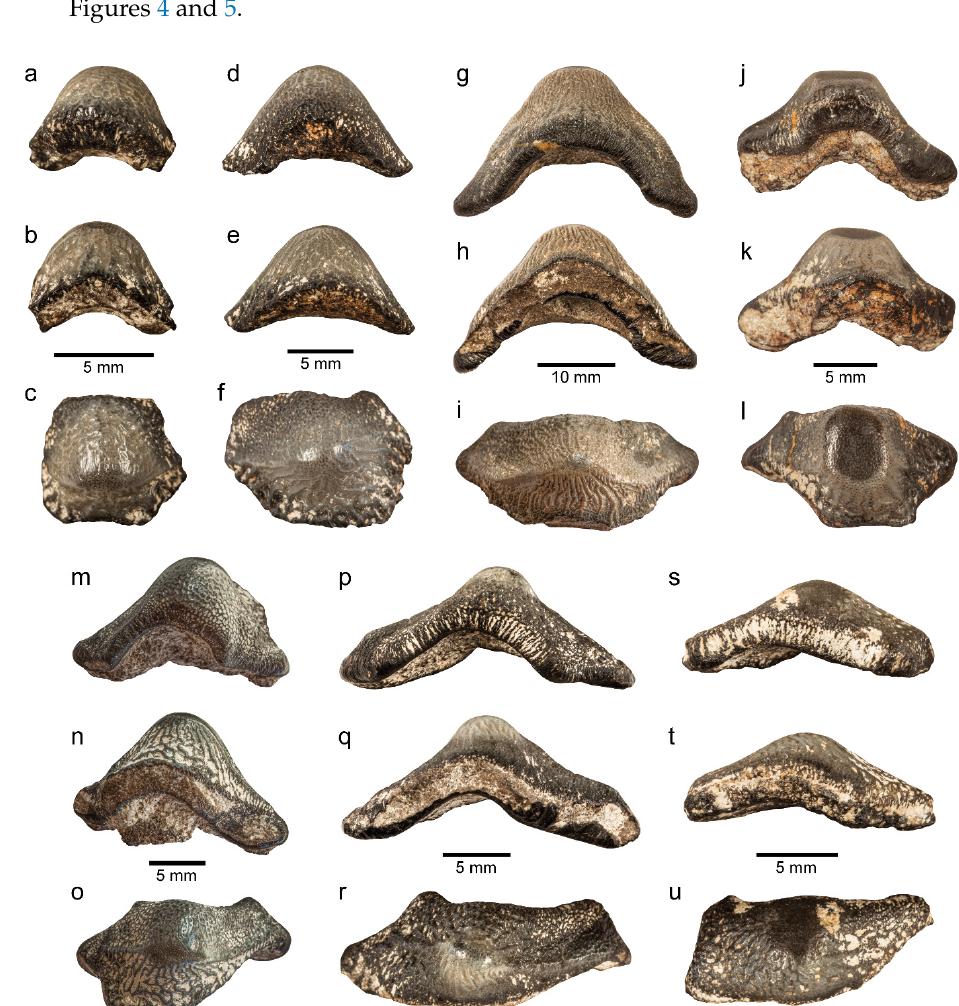
Figure 4. Historically collected hybodontiform teeth from the lower Kimmeridgian of Czarnogłowy, Poland. Strophodus udulfensis (Leuzinger et al., 2017). ( a – f ) Symphyseal teeth; GG 303/34 in ( a ) labial, ( b ) lingual and ( c ) apical view; GG 303/35 in ( d ) labial, ( e ) lingual and ( f ) apical view. ( g – i ) First anterior tooth; GG 303/36 in ( g ) labial, ( h ) lingual and ( i ) apical aspect. ( j – u ) Second anterior teeth; GG 303/37 in ( j ) labial, ( k ) lingual and ( l ) apical view; GG 303/38 in (m) labial, ( n ) lingual and ( o ) apical view; ( p – u ) second lateral teeth; GG 303/39 in ( p ) labial, ( q ) lingual and ( r ) apical view; GG 303/40 in ( s ) labial, ( t ) lingual and ( u ) apical aspect. Symphyseal teeth are short mesio-distally and strongly domed, displaying a sub- rectangular outline in occlusal view (Figure 4c,f). There is a weak transverse crest extend- ing across the occlusal face of the crown. The crown exhibits a complex ornamentation pattern consisting of frequently branching folds on the lingual half of the crown (Figure 4b,e) and reticulate folds on the labial half, which gives it a rough, more or less regularly pitted surface texture (Figure 4a,d).